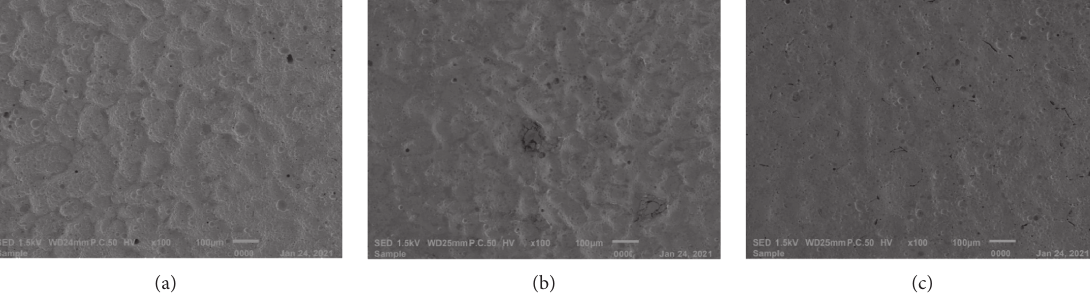
Figure 4: Corrosion surface morphology of the HNNS samples after their immersion in a 6% FeCl (N), (b) 1.28 wt.% (N), and (c) 1.37 wt.% N.